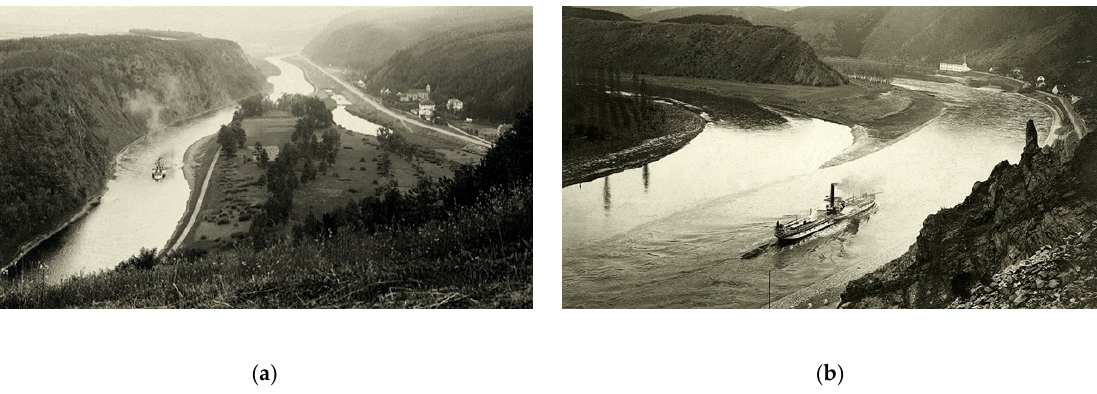
Figure 6. Photographs of the former island and its merge with mainland from the beginning of the 20th century from northeast ( a ) and north ( b ). Source: Josef Dvoˇr á k (http: // 20th century from northeast ( a ) and north ( b ). Source: Josef Dvo ř ák (http://www.dvorak-davle.cz).